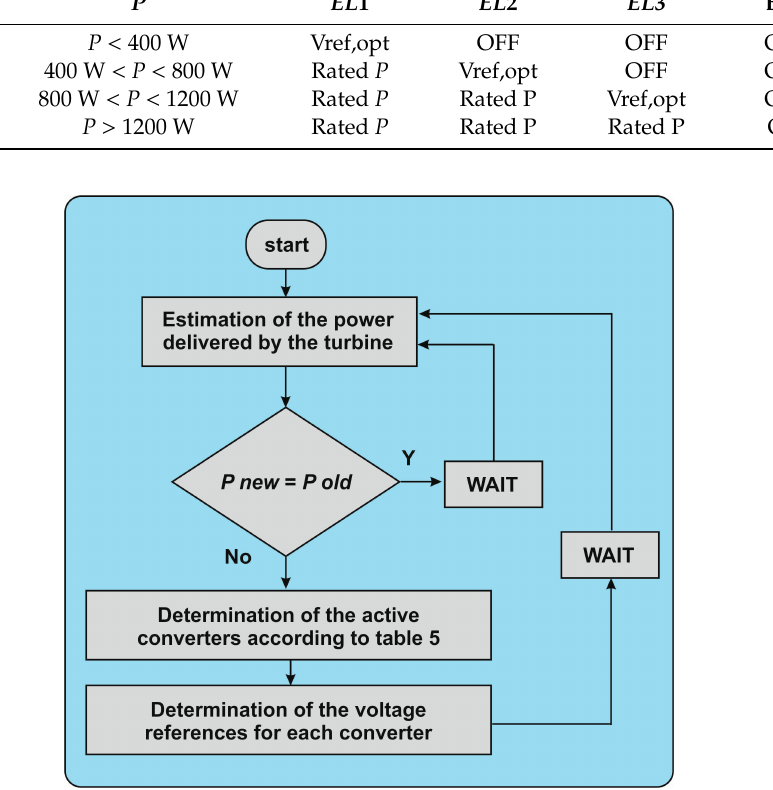
Figure 12. Flow chart of the energy-sharing algorithm.